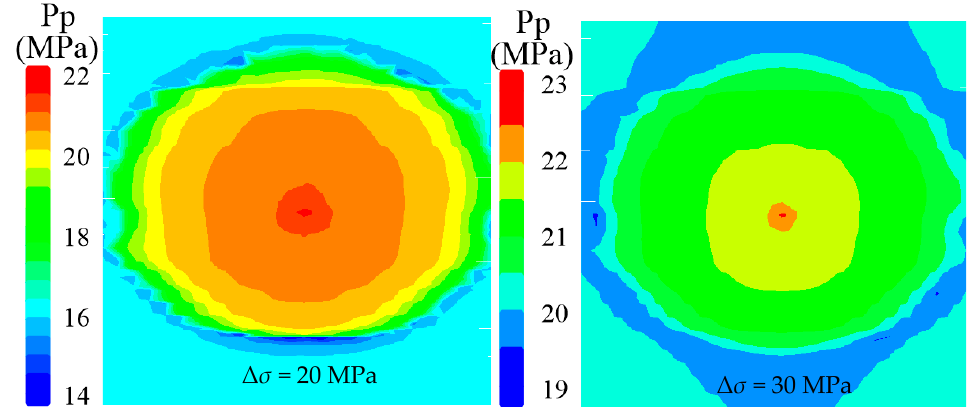
Figure 7. Fluid pressure distributions in different cases of stress configurations.